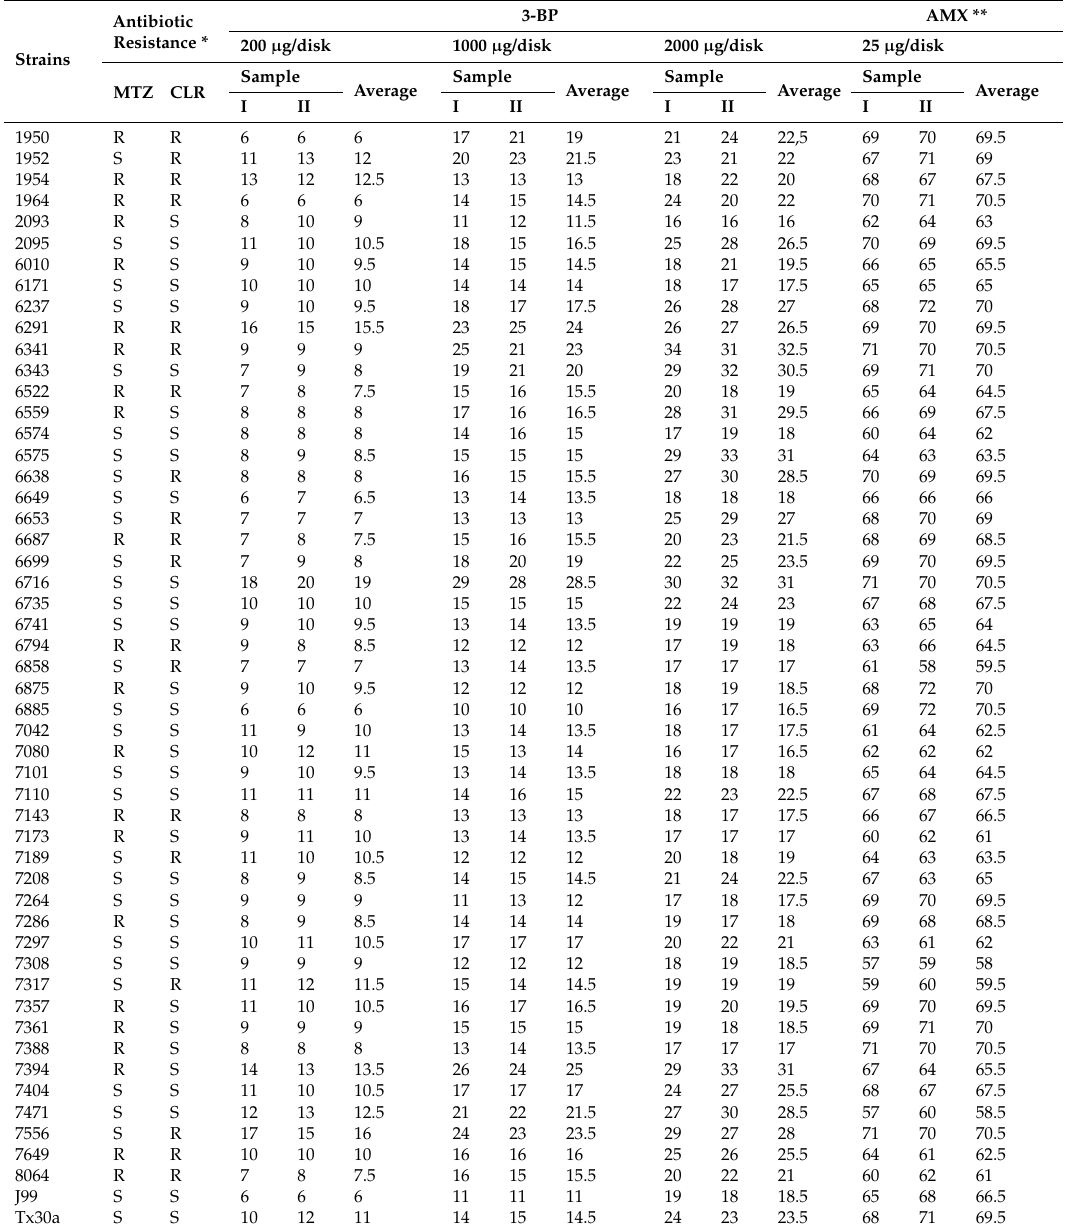
Table 1. The zones of inhibition (mm) of 3-Bromopyruvate (3-BP) against clinical and control H. pylori